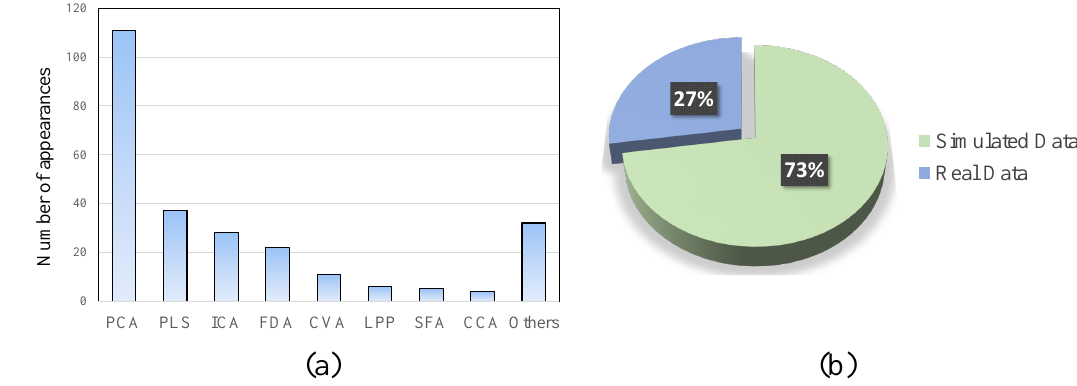
Figure 5. Yearly distribution of publications found in the literature review.